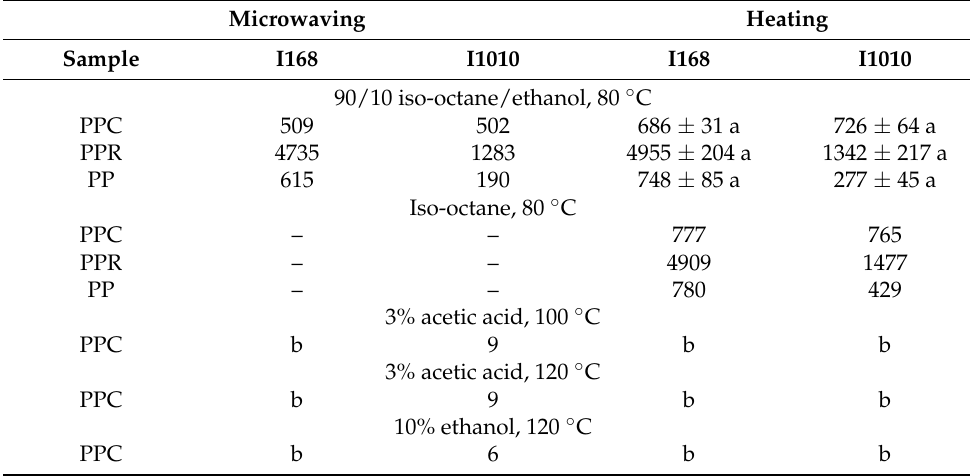
Table 11. Antioxidant migration under microwaving and heating